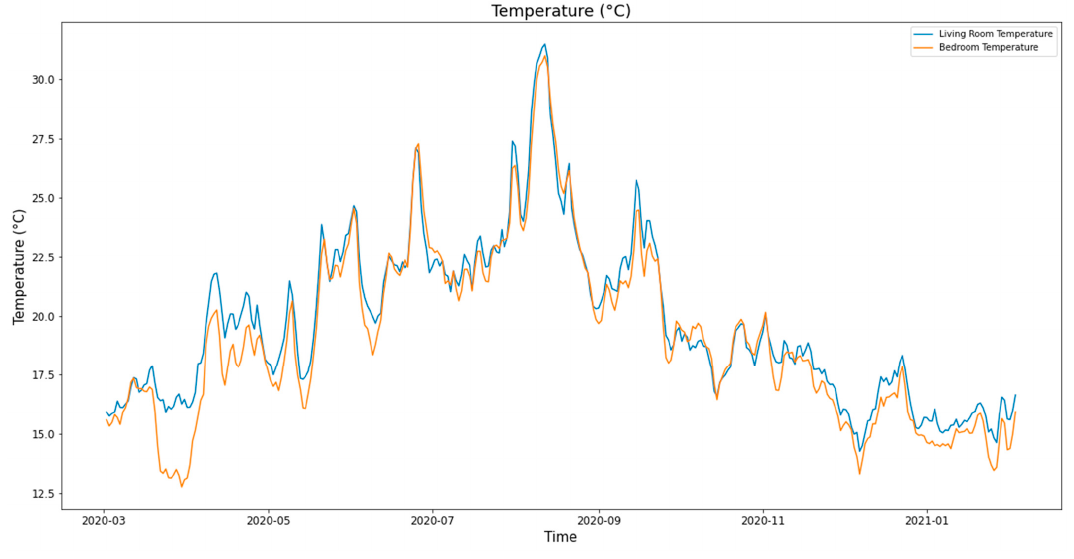
Figure 24. Temperature variation.